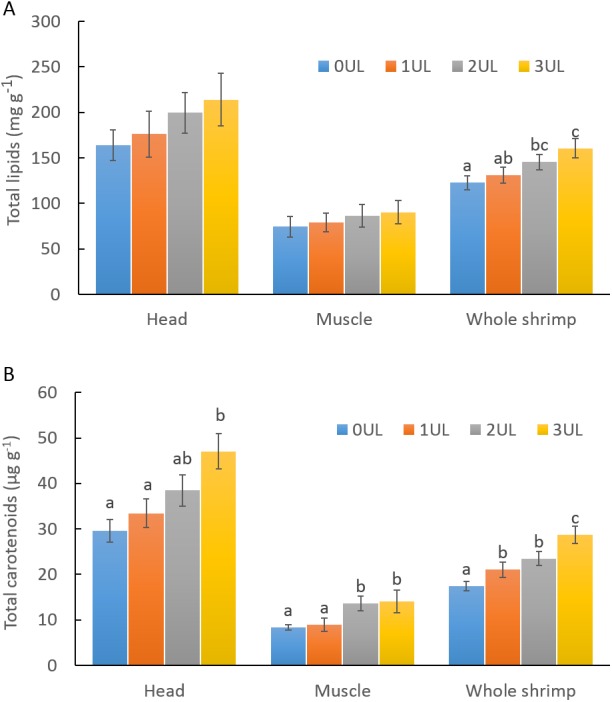
Total lipids and total carotenoid in shrimp fed experimental diets containing different inclusion levels of U. lactuca meal.(A) Total lipids and (B) Total carotenoids in shrimp fed experimental diets containing 0% (0UL), 1% (1UL), 2% (2UL) and 3% (3UL) of U. lactuca meal. Values are given as mean ± SD of multiple determinations (n = 5). Different superscripts denotes statistical differences among treatments (p < 0.05).